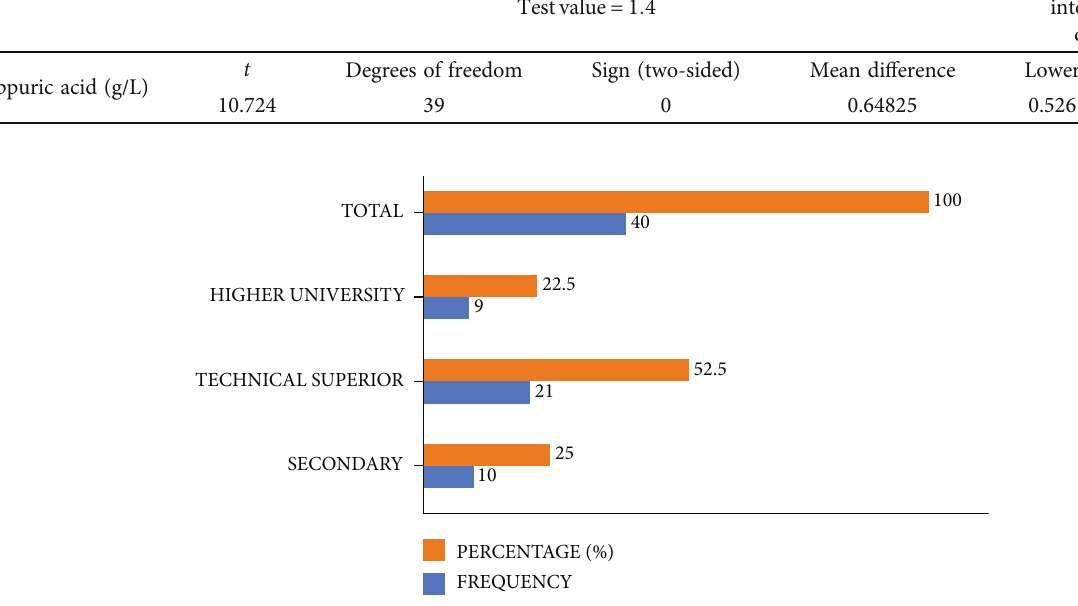
Figure 3: Results according to the level of instruction.